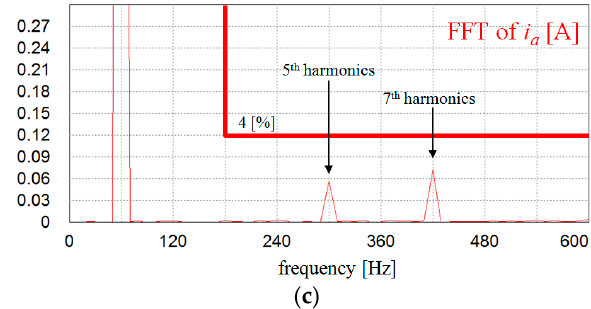
Figure 11. Comparison of inverter output currents under harmonic distorted grid condition. ( a ) Inverter output currents with voltage measurements; ( b ) inverter output currents with the proposed voltage-sensorless control; and ( c ) fast Fourier transform (FFT) result for a -phase current in ( b ). Figure 12 shows the estimation performance of grid voltages and corresponding inverter output current waveforms under different inductance variations. Even though the magnitude of current ripple is varied due to the different inductance values, the estimation performance of grid voltages is not affected by such a variation, which well proves the robustness of the proposed estimation algorithm.